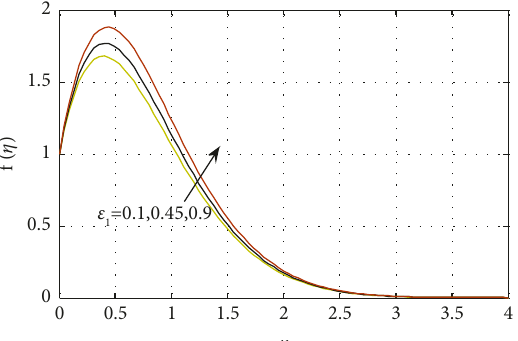
Figure 4: Impact of the parameter in variable thermal conductivity � 0 . 1 , Gr � 5 , ε � 0 . 1 , Gr on the velocity profile using A � 1 ,v 0 0 2 � 5 , β � 0 . 4 , β � 0 . 4 ,P � 4 R � 0 . 1 , S � 1 . 5 , c � 0 . 4. r d c 1 1 2